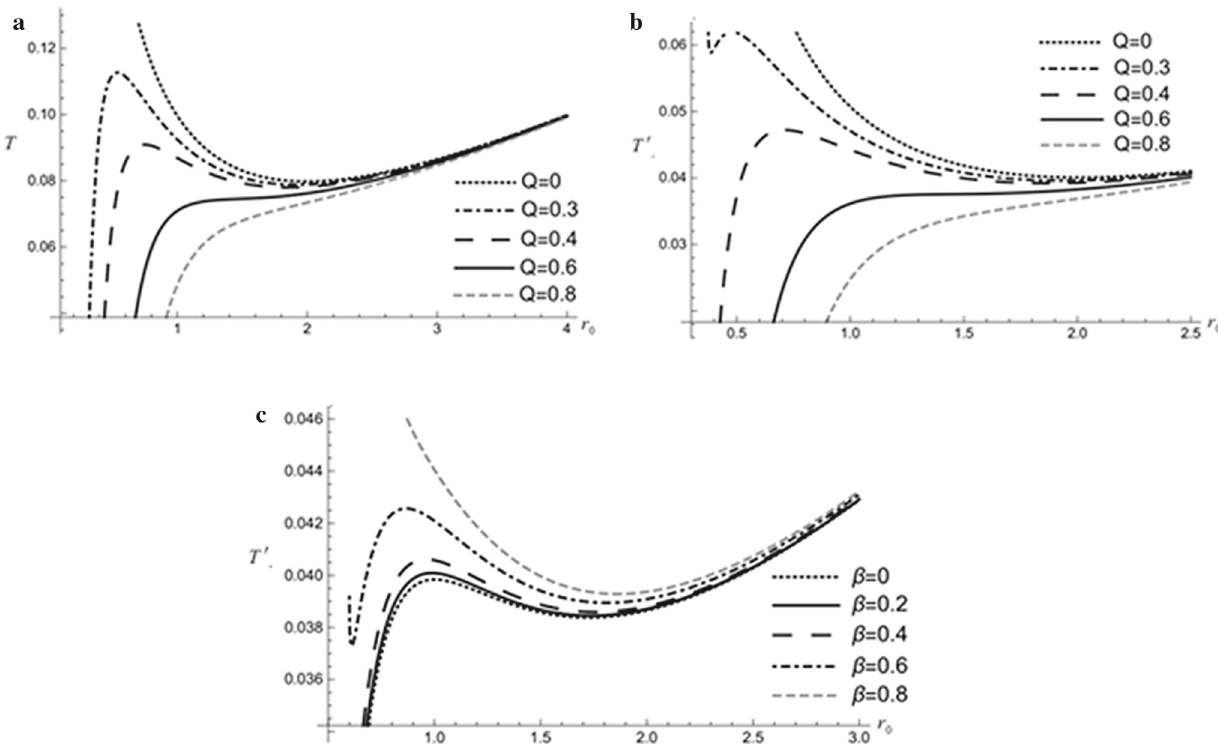
Fig. 1 a Thestandardtemperatureoftheblackholevs. r 0 . b TheGUP-correctedtemperaturevs. r 0 with β = 0 . 5. c TheGUP-correctedtemperature vs. r 0 with Q = 0 . 5. In all cases we take ¯ h = 1 , P = 0 . 01